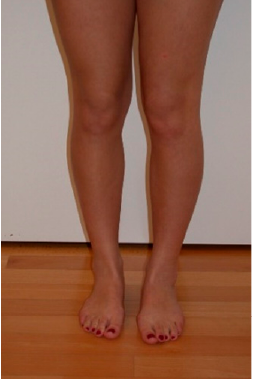
Figure 1. View from the front visualizing the squinting patellae with increased femoral antetorsion, the left side more than the right side.